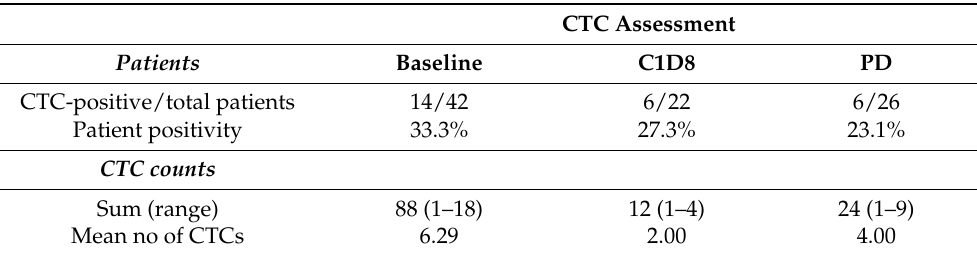
Table 2. Distribution of CTCs in patients with metastatic BC at different time points during eribulin treatment and on disease